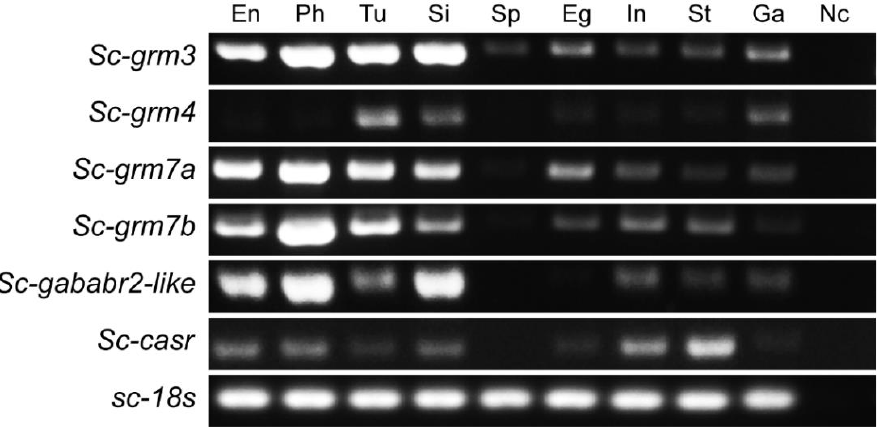
Figure 6. Tissue distribution of S. clava Class C GPCR transcripts by RT-PCR. The transcripts of six Class C GPCRs were detected in the tissues of S. clava adults. The tissue abbreviations: En, endostyle; Ph, pharynx; Tu, tunic; Si, siphon; Sp, sperm; Eg, eggs; In, intestine; St, stomach; Ga, cerebral ganglion. Nc stands for negative control (no cDNA template in reaction). S. clava 18s rRNA ( Sc-18s ) was used as the reference gene.